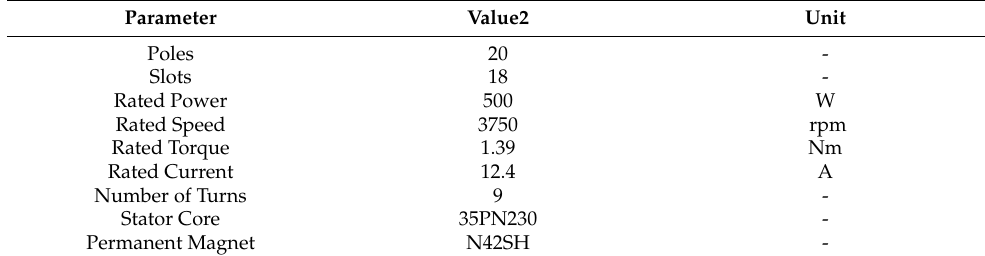
Table 1. Target RFPM motor specification.